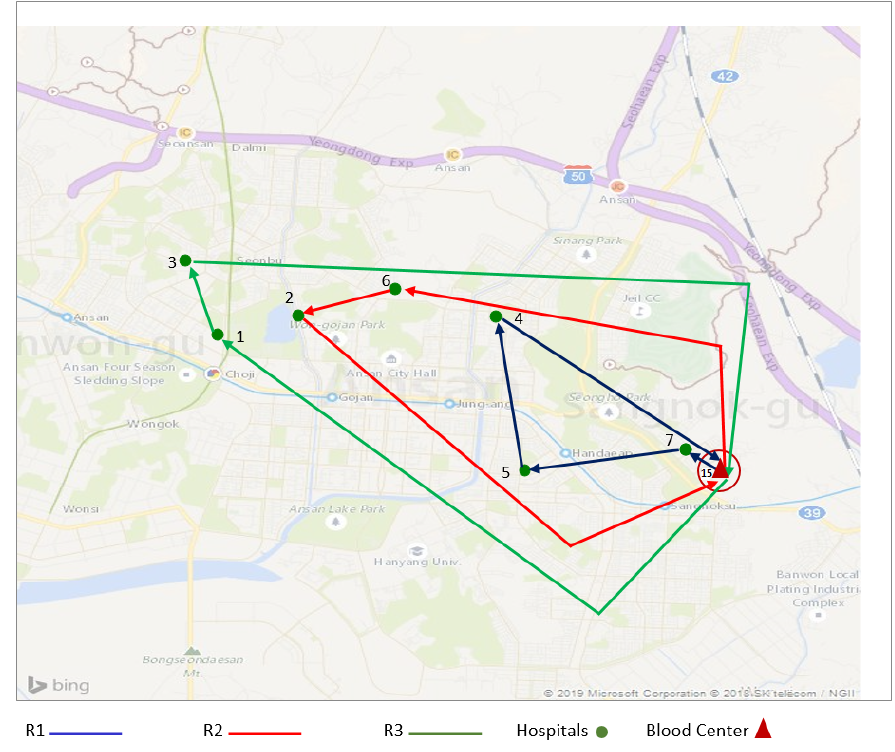
Figure 6. Optimal routes between hospitals and the blood